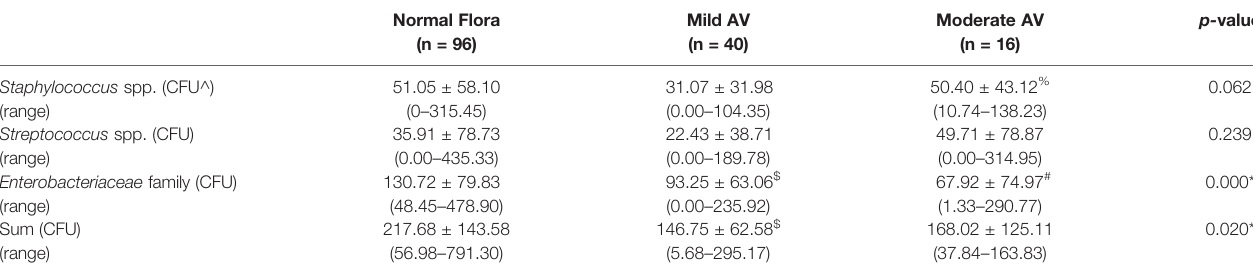
TABLE 2 | The amount of aerobic bacteria in the vaginal discharge of pregnant women with aerobic vaginitis (AV) using real time PCR (qPCR).